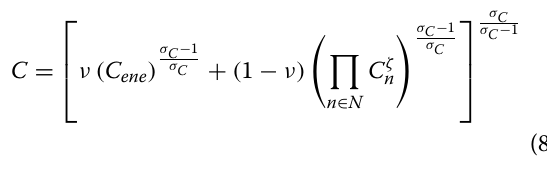
In every period, the total consumption C (we omit the temporal subindex) includes the consumption of energy ( C ene ) and the composite of non-energy goods with an elasticity of substitution σ C ;